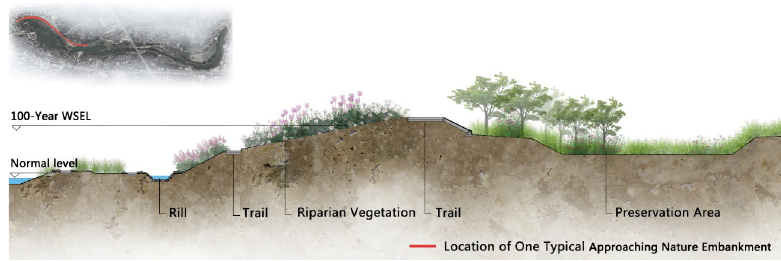
Figure 3. Cross-section of one typical approaching nature